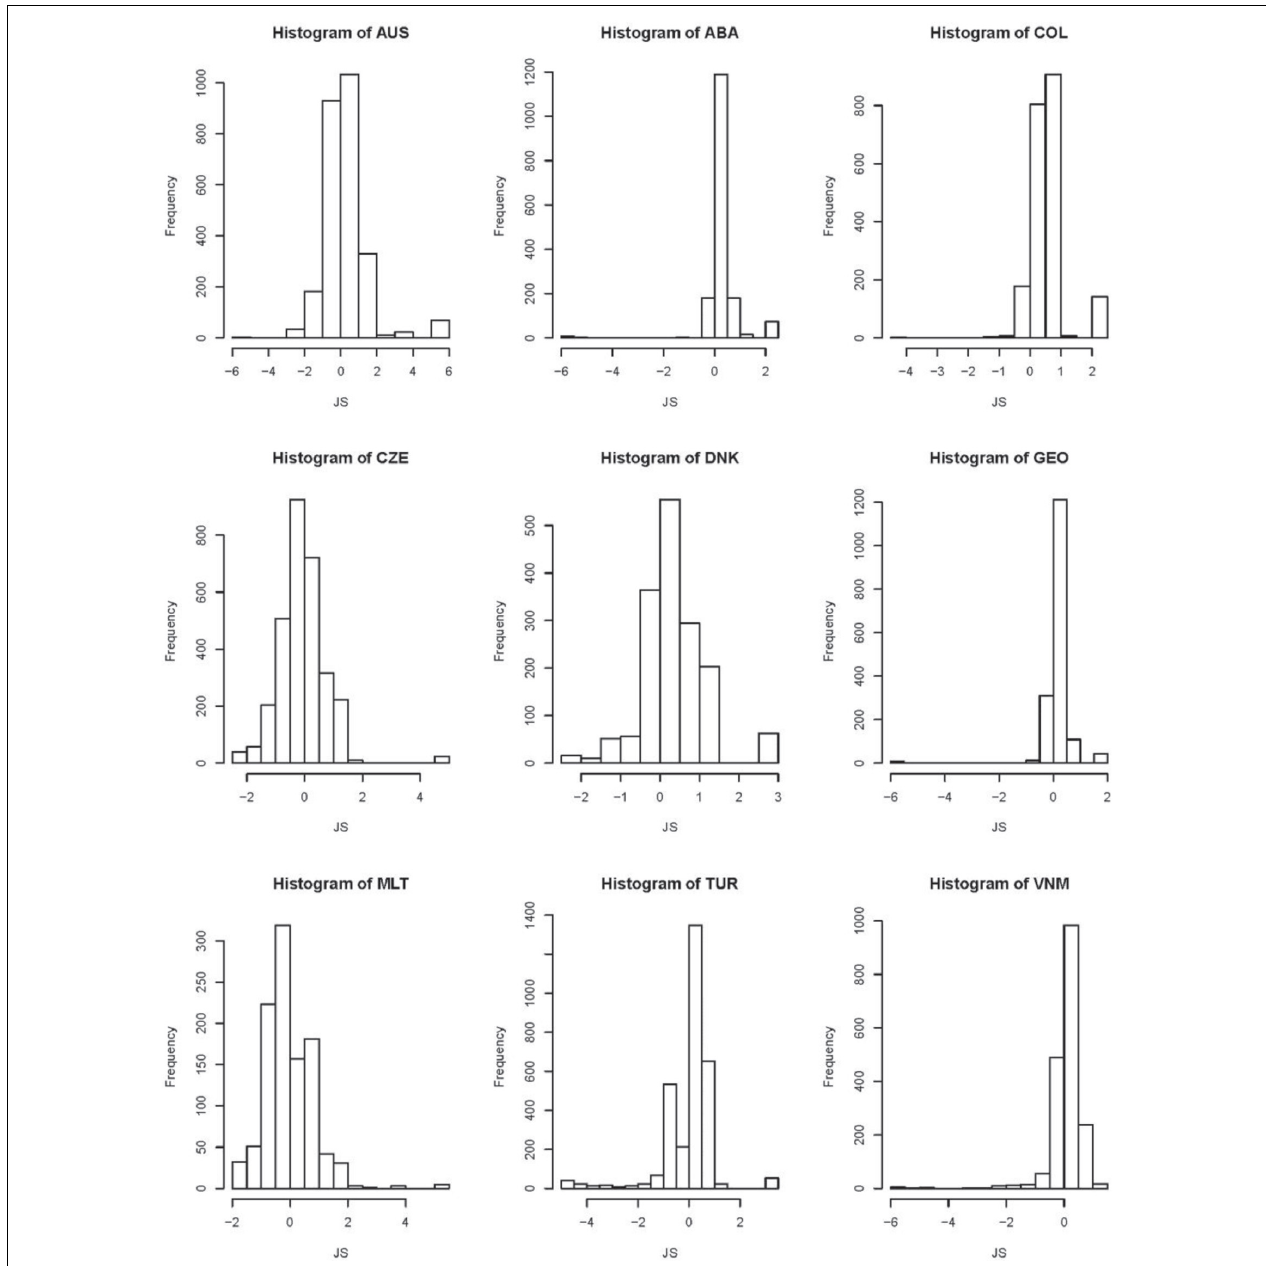
FIGURE 4 | Histogram plots of latent traits (LTs) measured job satisfaction (JS).